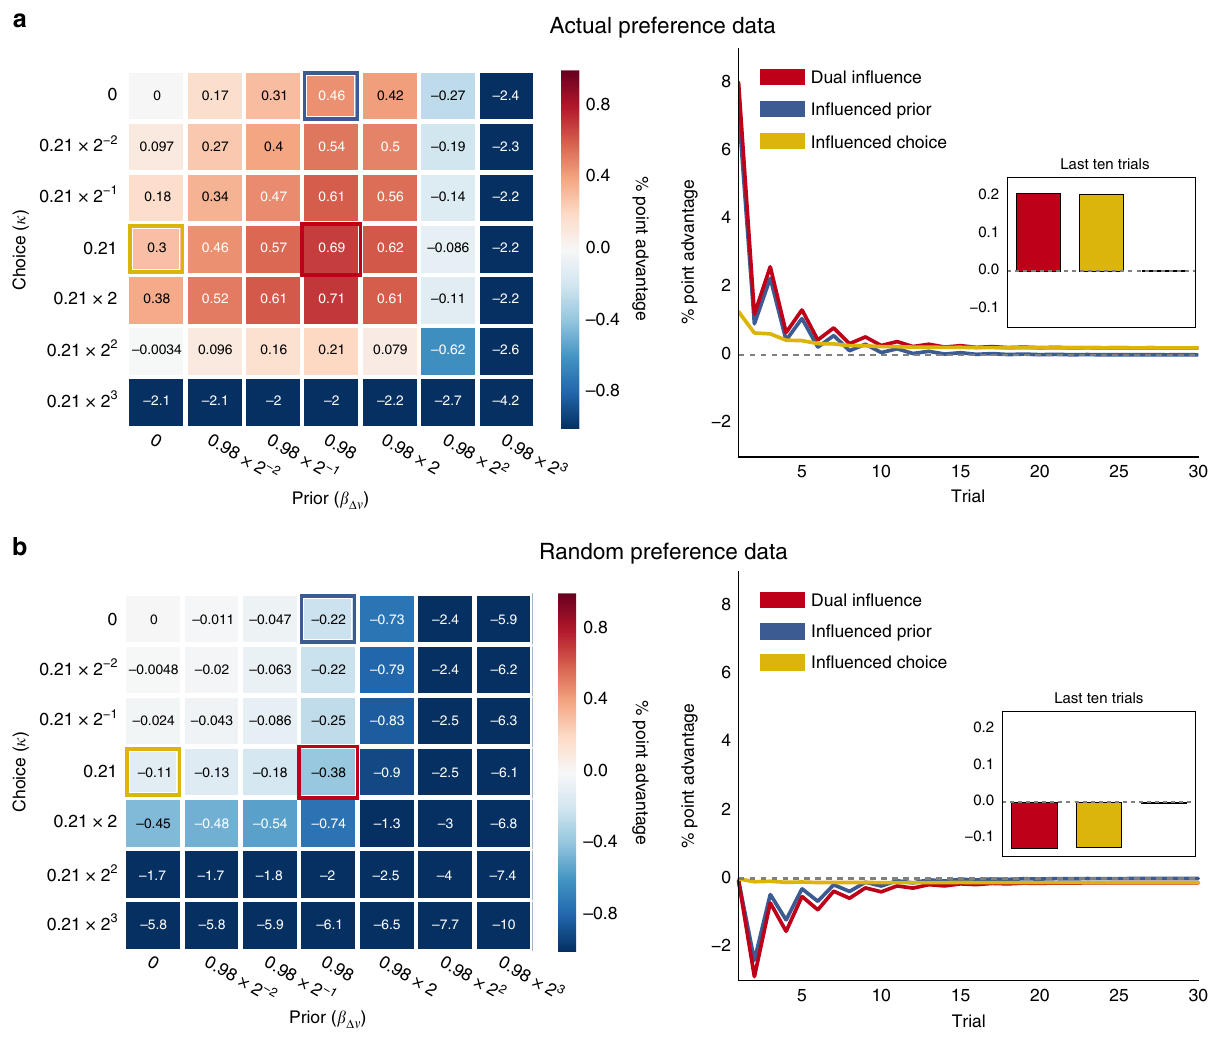
Fig. 7 Simulated mean performance advantages conferred by different loci of preference in fl uence. a A dual in fl uence strategy, which combines in fl uences of preference on both the prior and the choice bias, results in the greatest average performance in our simulated task using actual preference data. The heat map ( left ) shows the percentage point advantage over a neutral actor for different combinations of choice (vertical axis) and prior (horizontal axis) parameter values, centered at the actual means of the group mean parameter estimates from our dual in fl uence model (highlighted in red ), estimated from participants in the non-social group. This strategy outperforms both in fl uenced choice ( yellow ) and in fl uenced prior ( blue ) strategies. An in fl uenced prior strategy confers a substantial performance advantage at the beginning of learning ( right ), but which disappears after learning has plateaued (inset). By contrast, an in fl uenced choice strategy confers a smaller advantage at the beginning of learning, but it continues to slightly outperform a neutral actor even after learning has plateaued. The dual in fl uence strategy combines these advantages for a performance boost not only at the beginning of learning but also after learning has plateaued, leading it to outperform the three other strategies. b When preference data are generated randomly, and therefore not predicted by a participant ’ s own preferences, being in fl uenced by one ’ s own preferences results in a performance disadvantage compared to a neutral strategy. Performance is indicated in terms of the percentage point difference in correct responses between the indicated strategy and a neutral actor with identical drift weight ( ω = 1.53) and threshold ( a = 2.10) parameters, which were set to the means of the group mean parameter estimates recovered